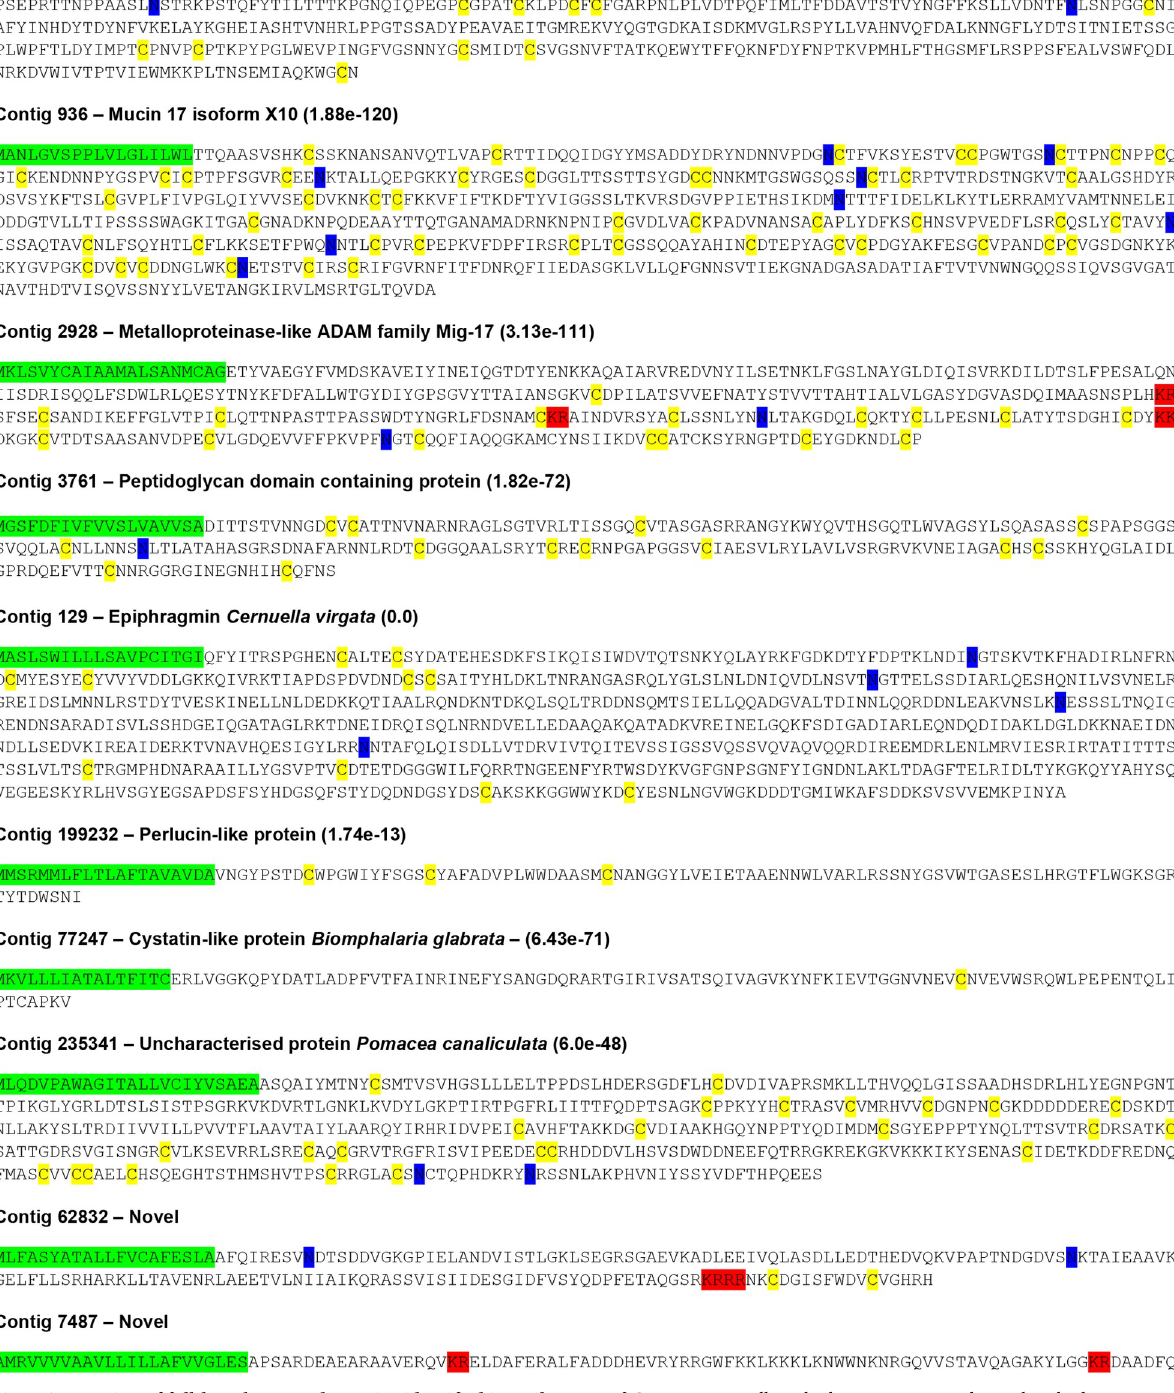
PLOS ONE | https://doi.org/10.1371/journal.pone.0251565 May 27,